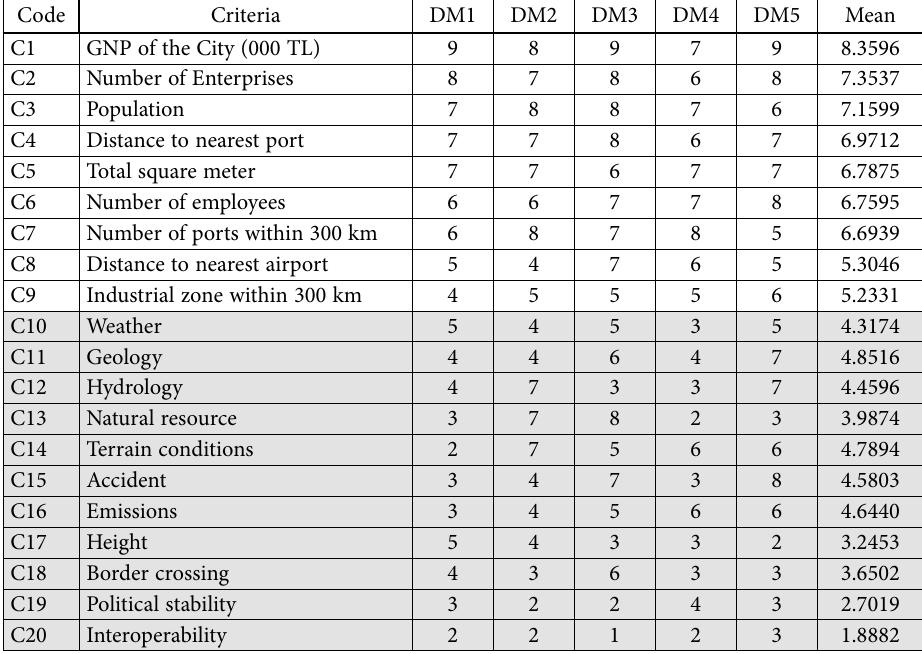
Table 4. The selection criteria for second-hand Ro-Ro Vessels and relative importance scores